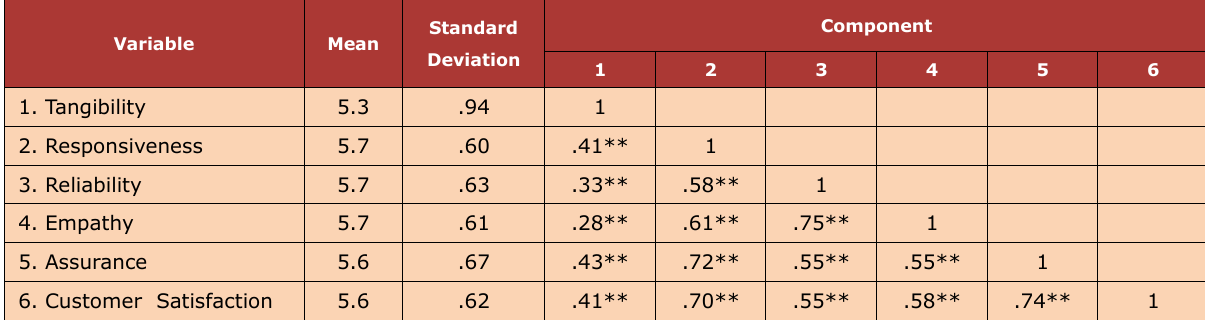
Table 4. Pearson Correlation Analysis and Descriptive